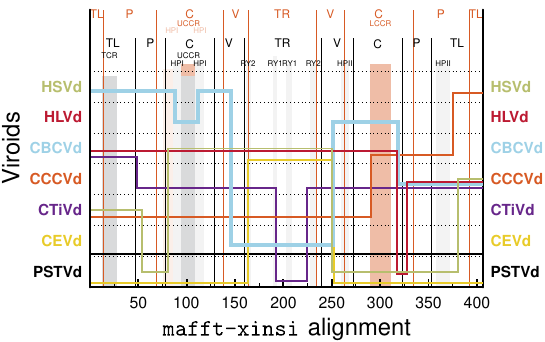
Figure 5. Similarity of CBCVd to other viroids. Domain borders and motifs of CCCVd and PSTVd are marked and labeled in orange and black, respectively, at the top. JA LI output with a seed alignment of HSVd (genus Hostuviroid ), HLVd, CBCVd, CCCVd, CTiVd ( Cocadviroid ), CEVd, and PSTVd ( Pospiviroid ). The seed alignment of the respective consensus sequences (Figure S17) was produced with MAFFT X-INS- I .